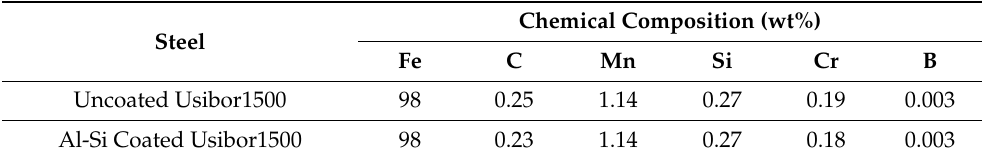
Table 1. Chemical composition of Usibor1500 steel.